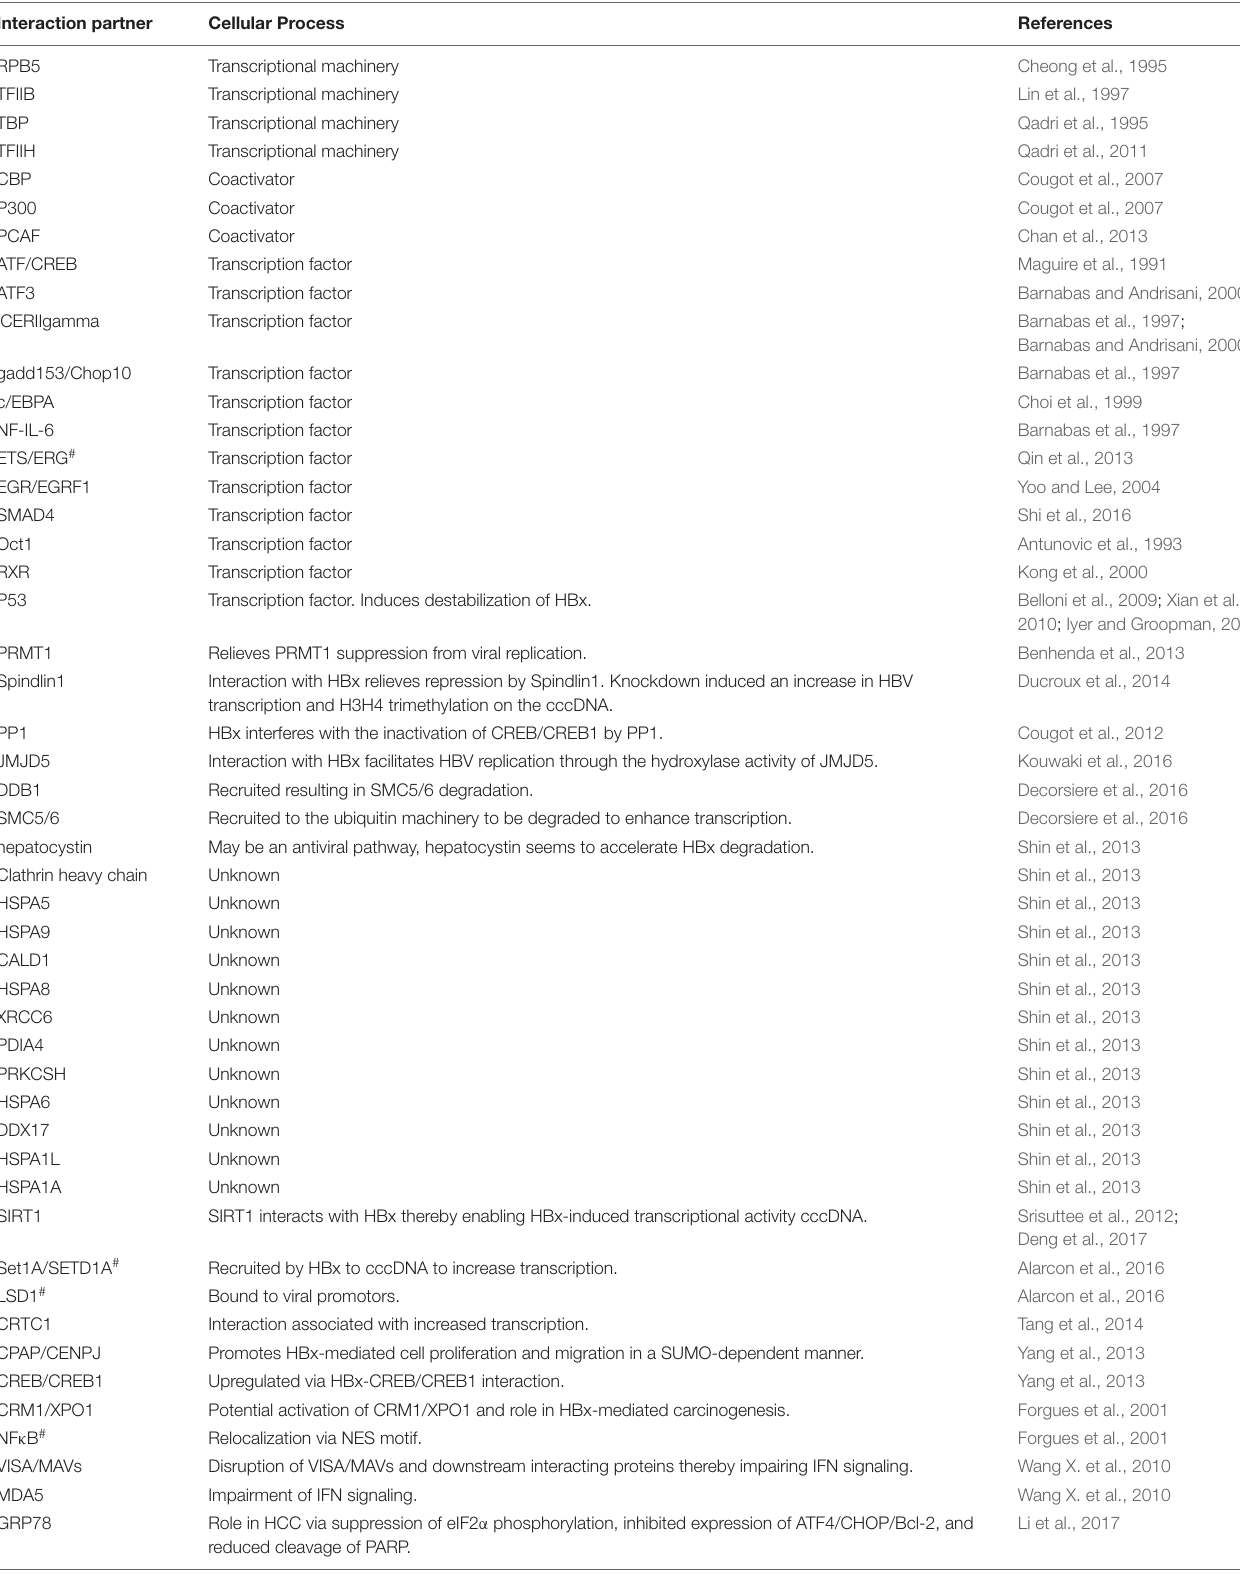
TABLE 2 | HBx interacting proteins listed together with the cellular processes or pathways in which they are involved. Interaction partner Cellular